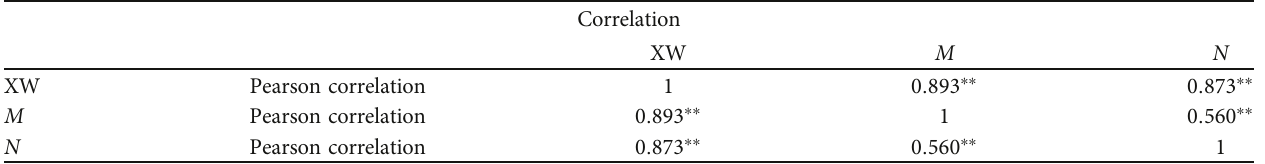
T ABLE 19: Correlation between the score of behavioral factors (XW), autonomous learning behavior in class ( M ), and extracurricular autonomous learning behavior ( N ) of the tested